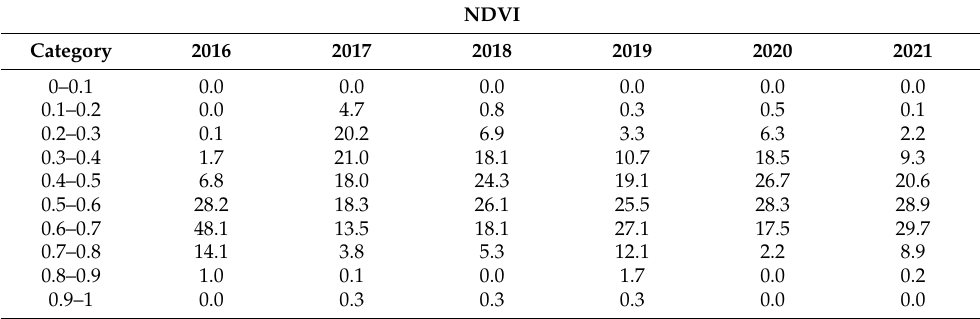
Table A2. Territorial spread (in %) of the individual categories divided for each of the spectral indices within the study area. This table represents the values behind the output rasters from Figure